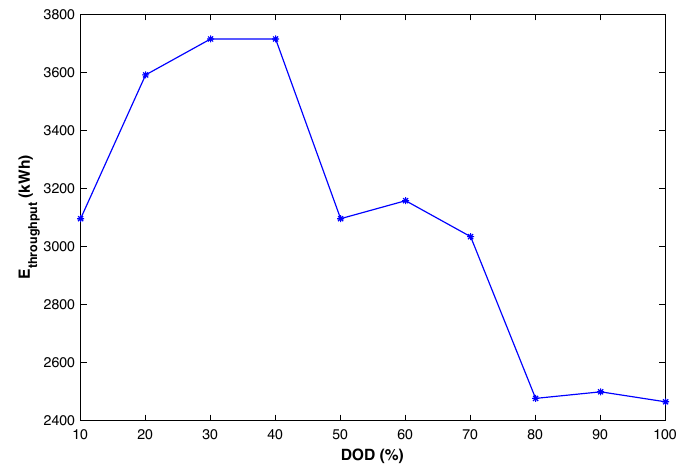
Figure 2. The relationship between energy throughput and